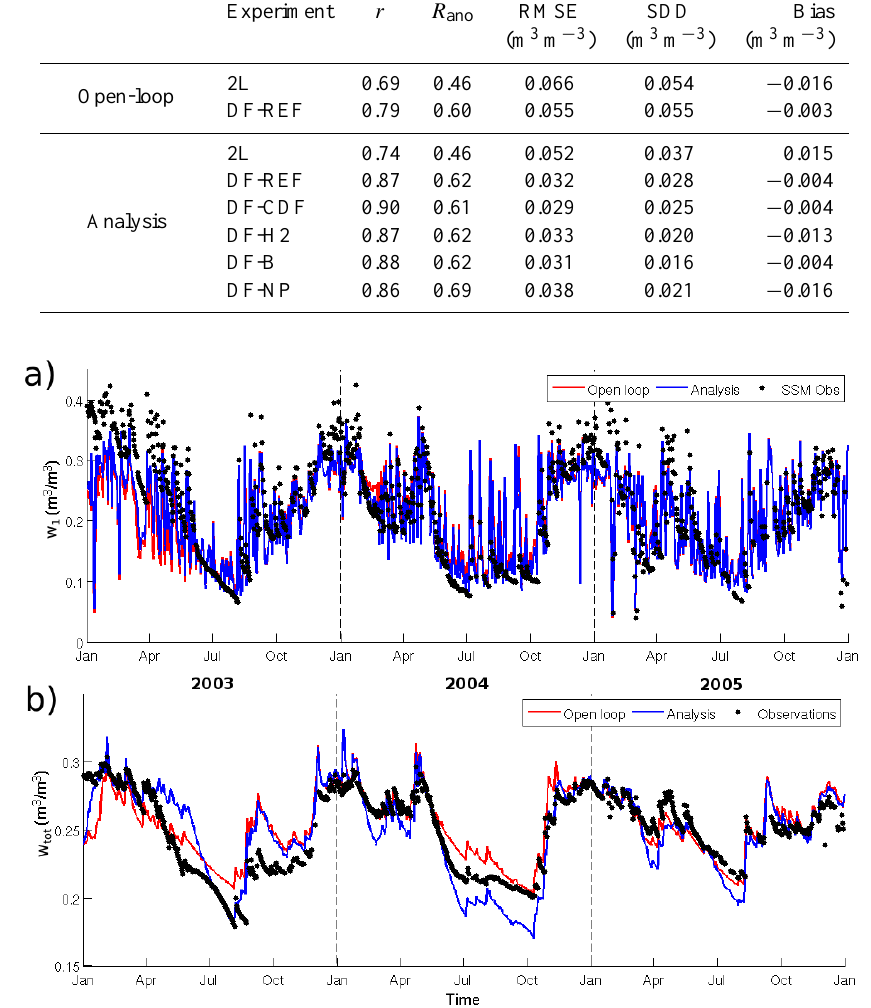
Fig. 4. 2L time series of open-loop simulation (red line), analysis simulation (blue line) and SSM observations at the SMOSREX site (black dots) for 2003–2005: in the surface layer (a) and in the total reservoir (b) . The units are in m 3 m − 3